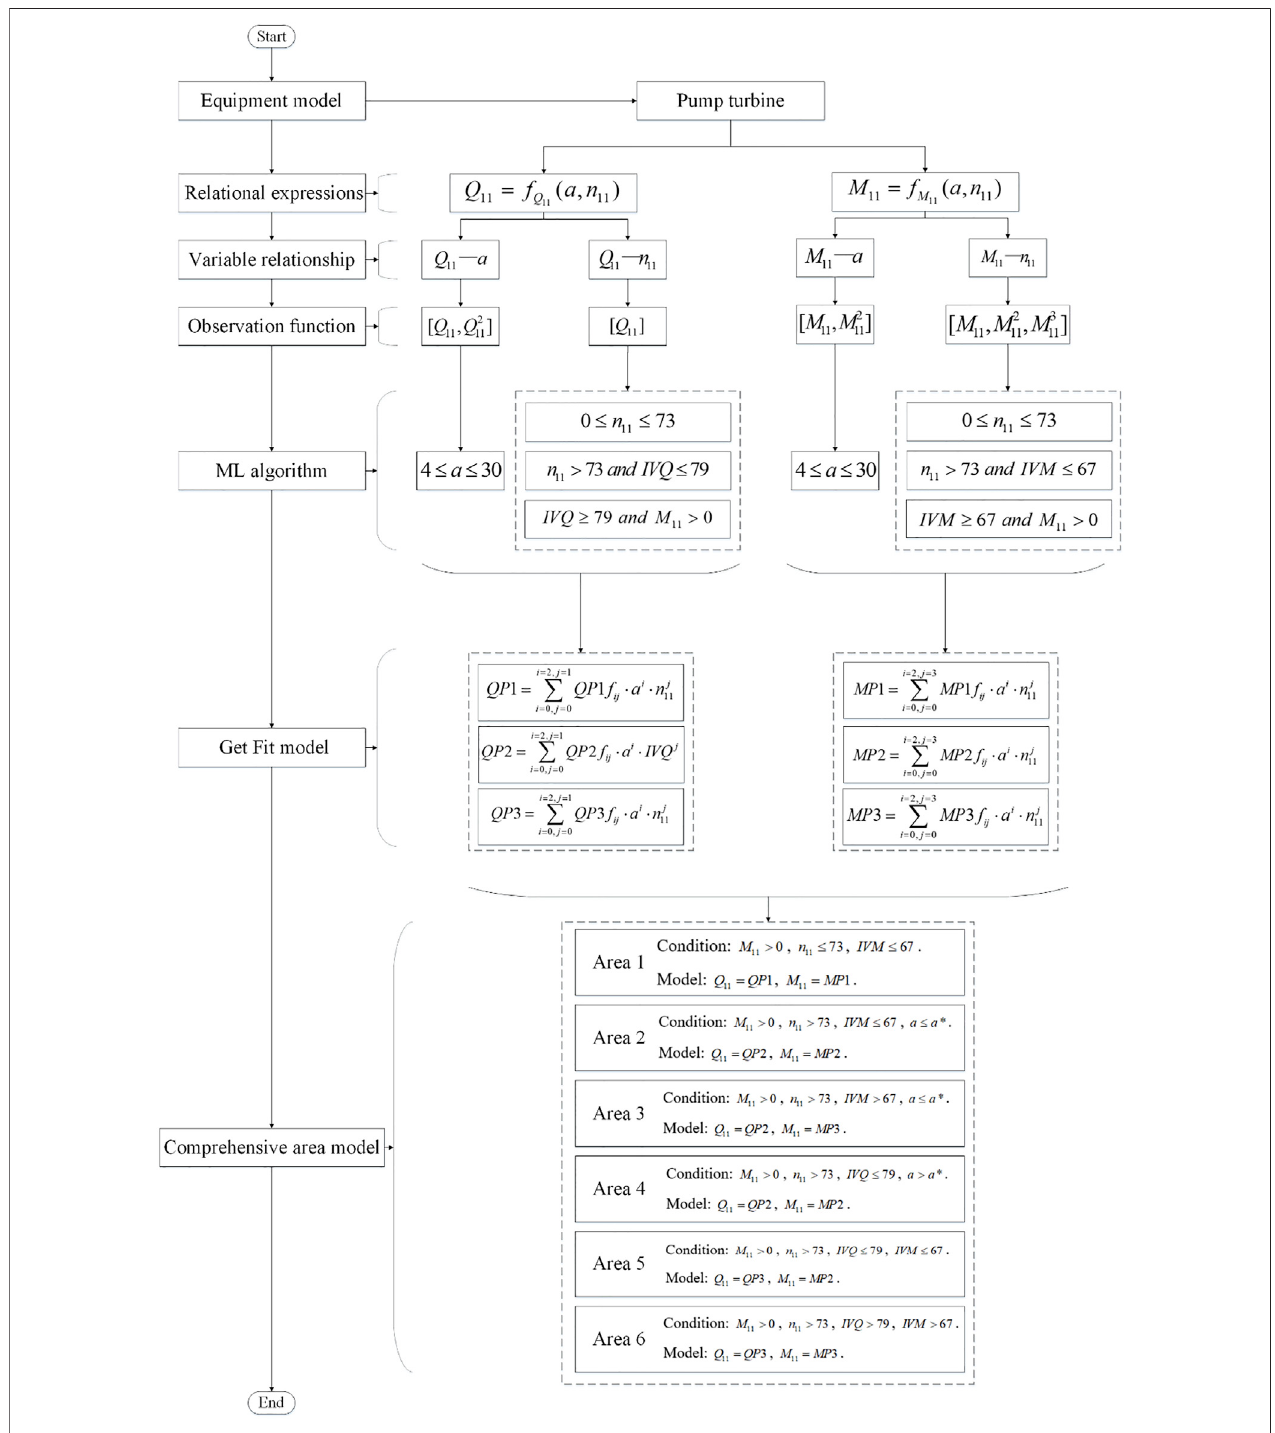
FIGURE 3 | The partition modeling fl